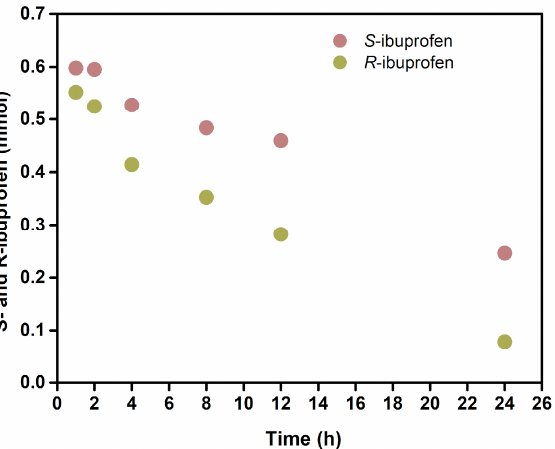
Figure 7. Amount of the S- and R -enantiomers versus time upon esterification of rac -ibuprofen ◦ C with isooctane as co-solvent. with ethanol at 45 °C with isooctane as co-solvent. ethanol at 45